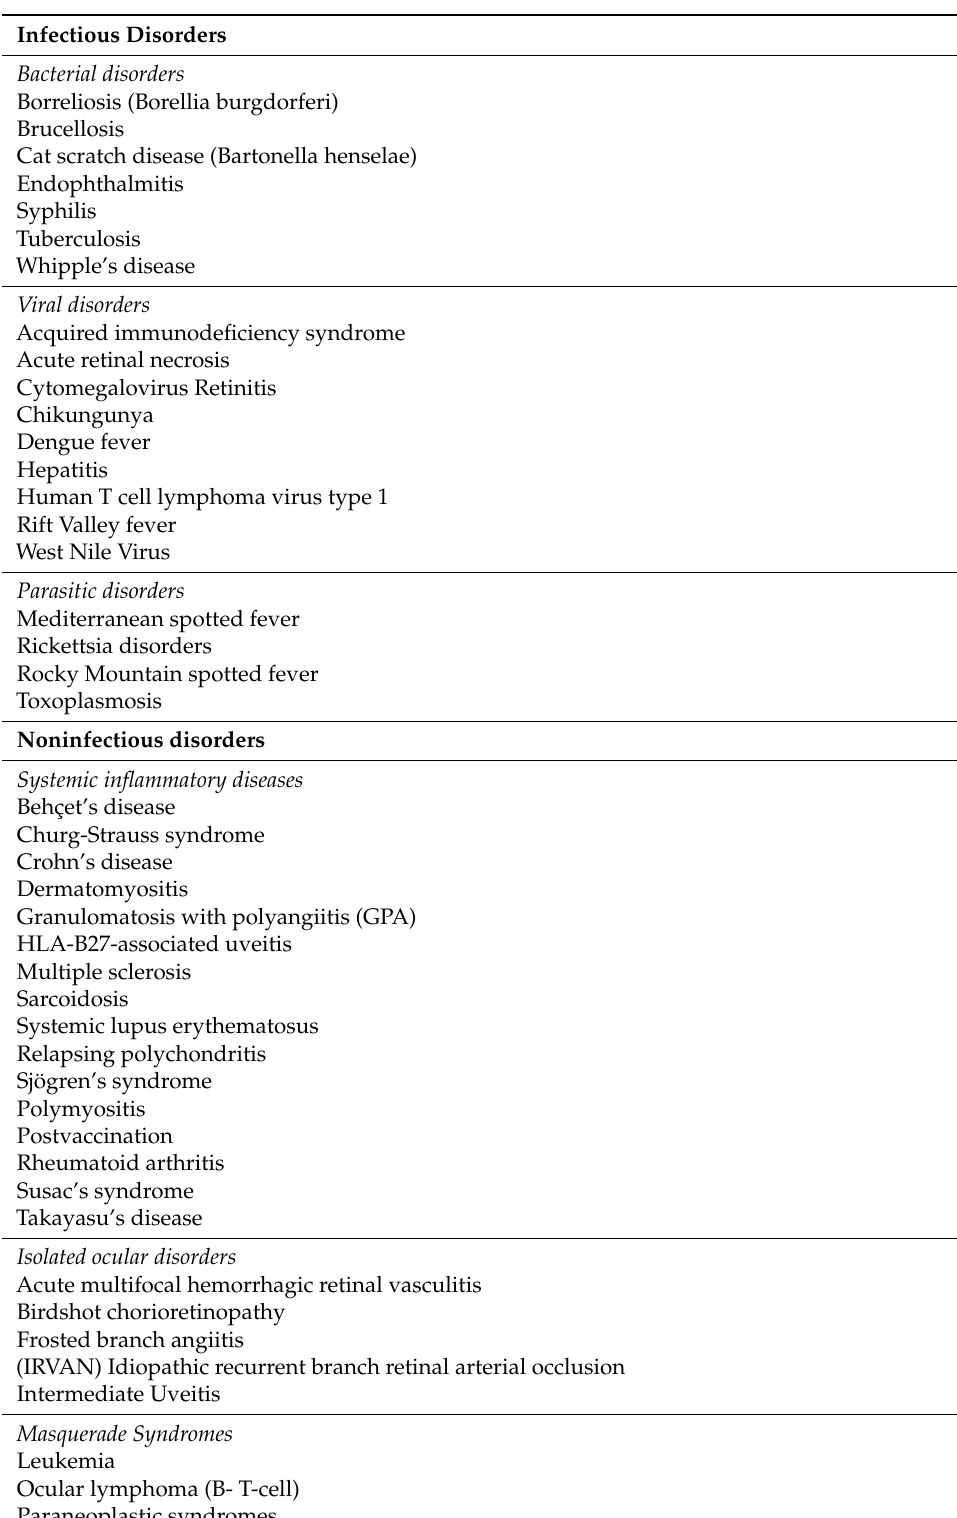
Table 1. Disorders associated with retinal